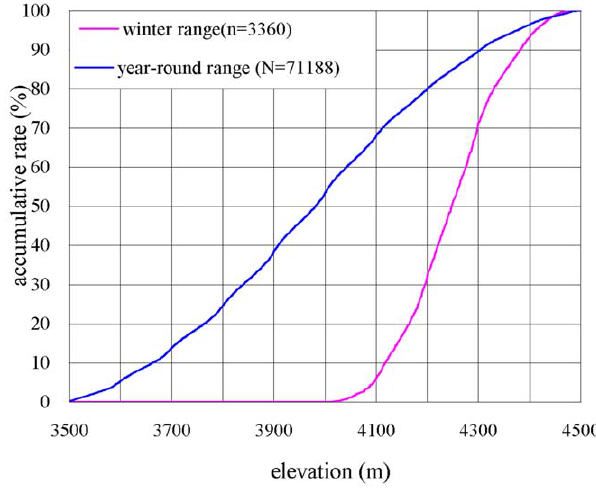
Figure 1. The cumulative percentage of area for winter home range and year-round home range along with elevation (3501– 4500 m).